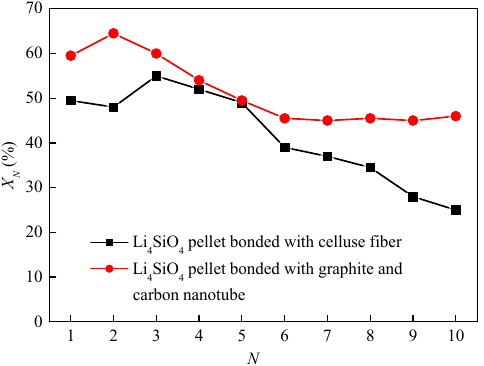
Figure 11. Cyclic CO 2 absorption by Li 4 SiO 4 materials with different binders [74,75].